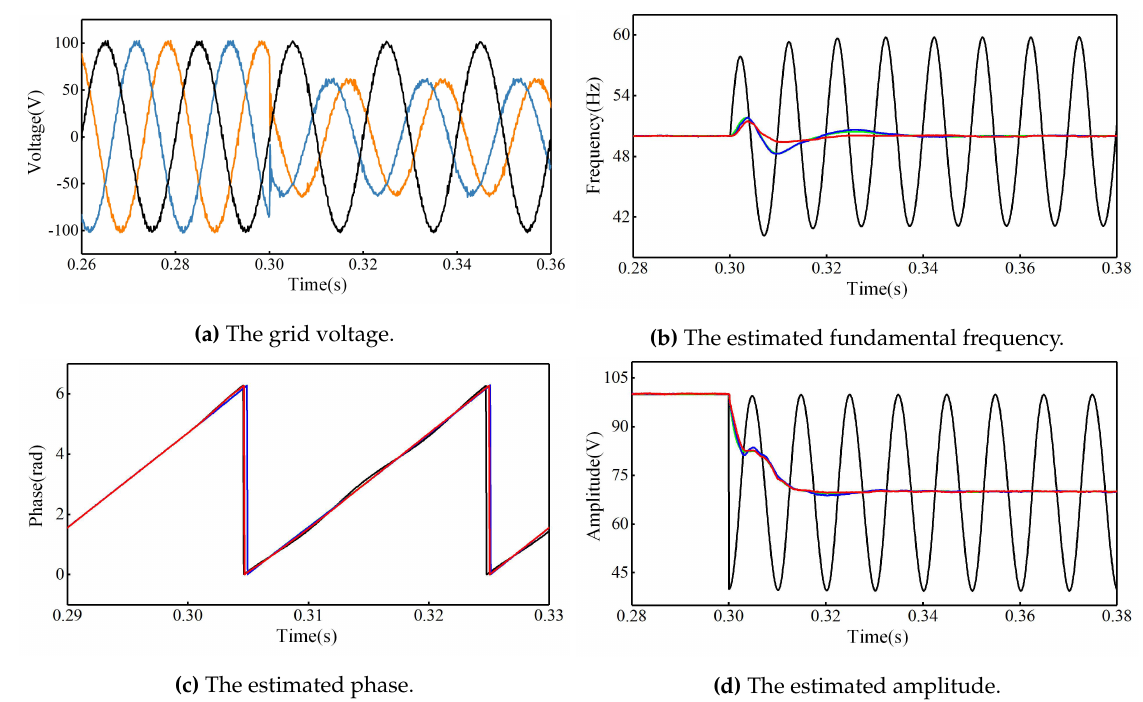
Figure 11. Waveforms of the grid voltage and estimated parameters by SRF-PLL (black line), DDSRF-PLL (green line), MCCF-PLL (blue line) and MDSOGI-IFLL (red